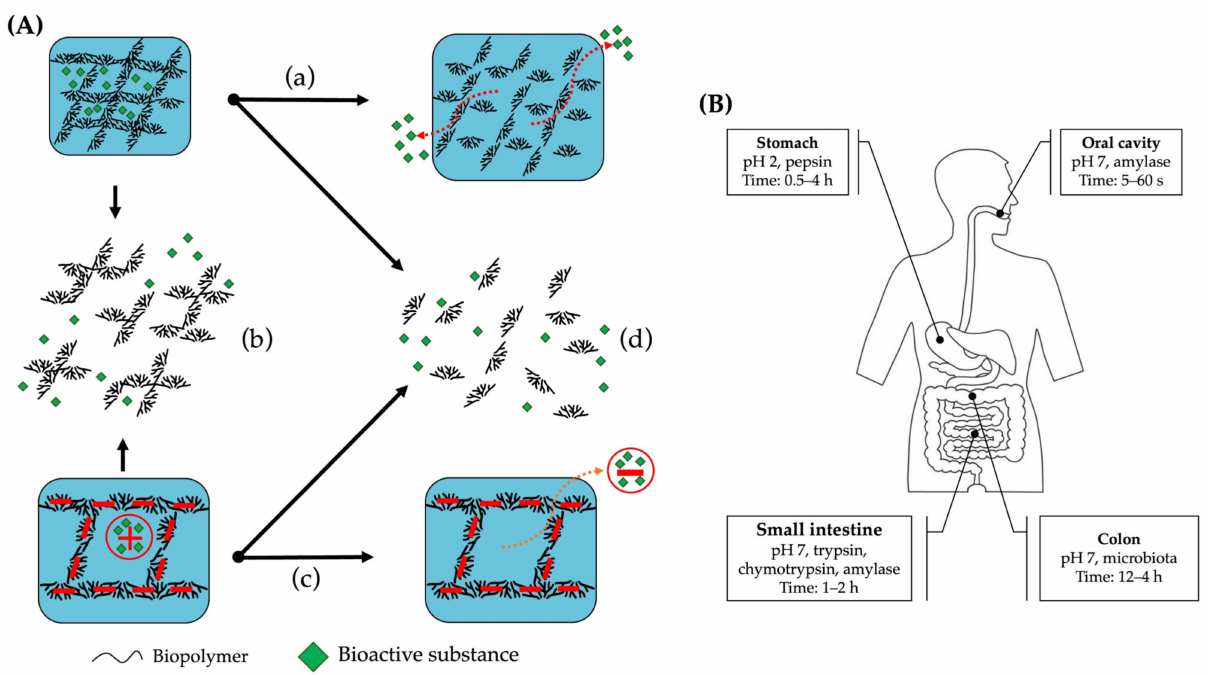
Figure 9. Food hydrogel and the digestive system interaction. ( A ) Potential pathways for targeted compound release from hydrogels: ( a ) swelling; ( b ) disintegration; ( c ) molecular interaction; ( d ) rrosion. ( B ) Schematic representations of physiological conditions (pH, enzyme, and retention time) of the gastrointestinal tract